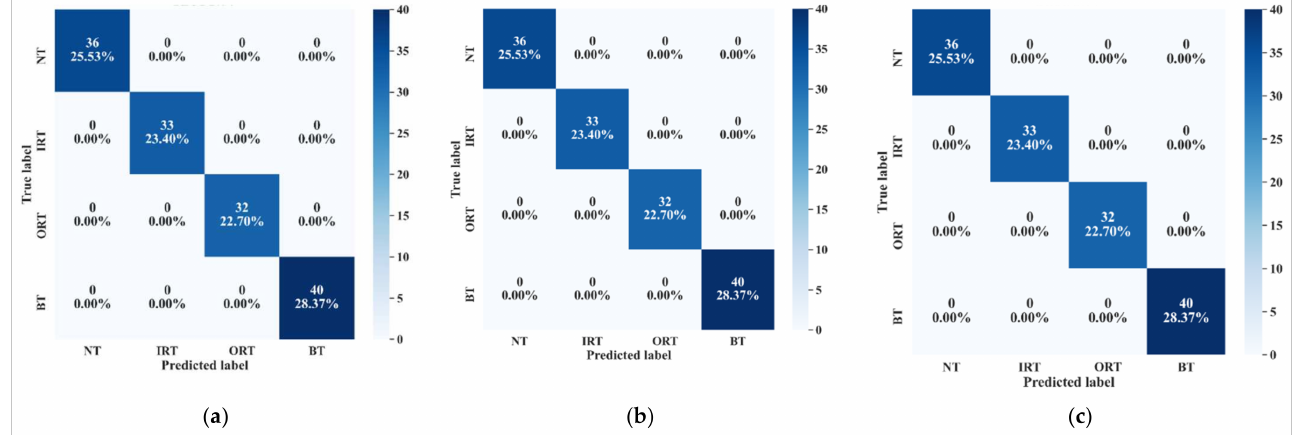
Figure 14. The confusion matrices of the three models that demonstrate the class-wise test accuracies, i.e., ( a ) dataset 1, ( b ) dataset 2, and ( c ) dataset3.